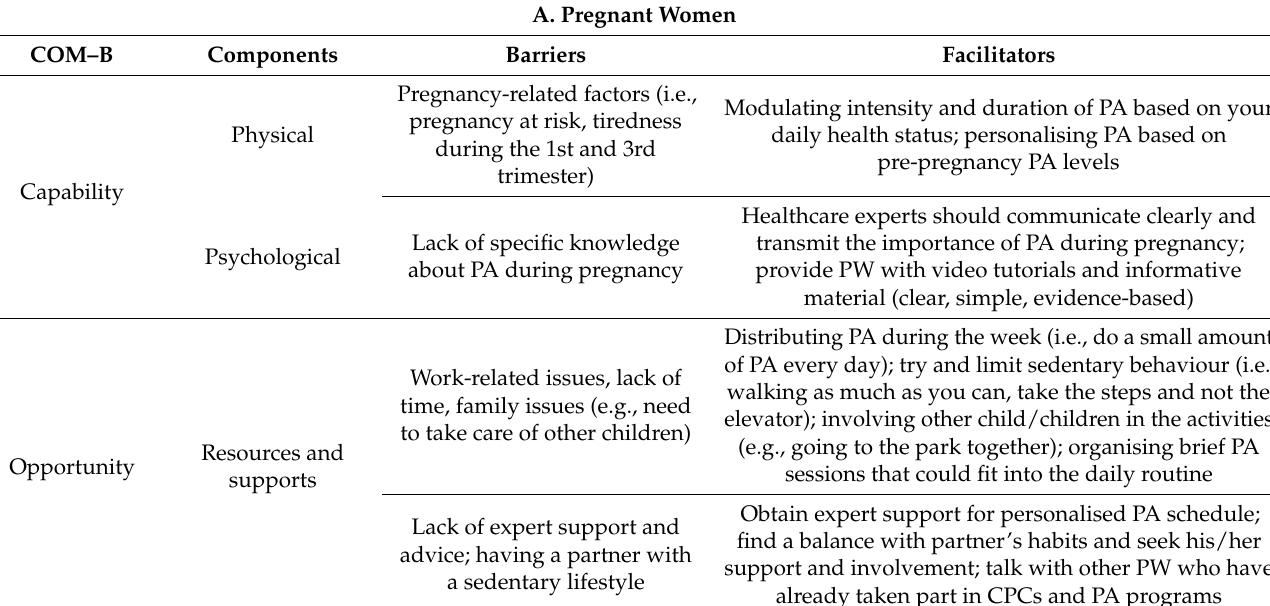
Table 1. A. Barriers and facilitators for practising PA among pregnant women using COM–B frame- work. B. Barriers and facilitators to physical activity implementation among midwives across COM–B